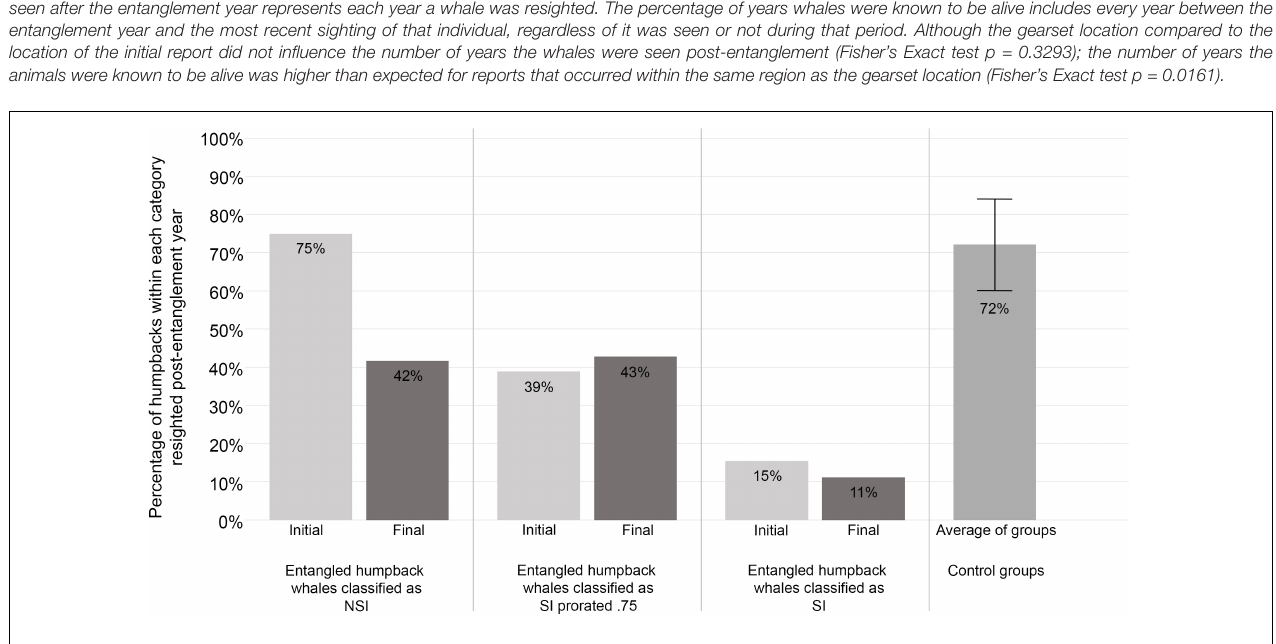
TABLE 3 | Gearset location compared to the location of the initial report. Reported inside the same region gear was set (n = 9)